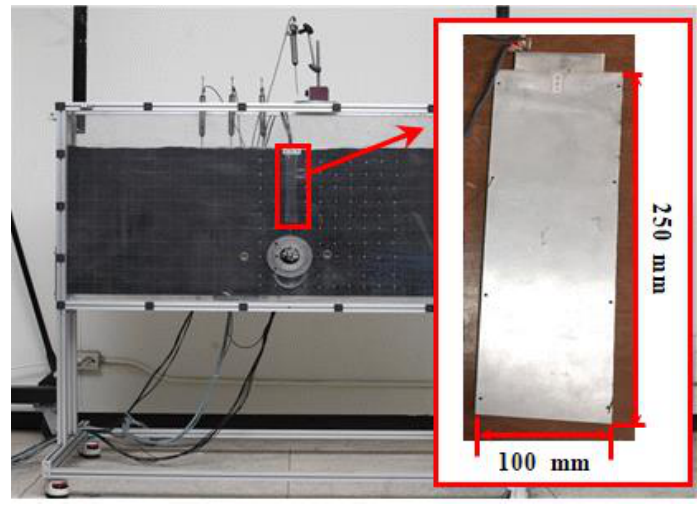
Figure 6. Single pile for model test.